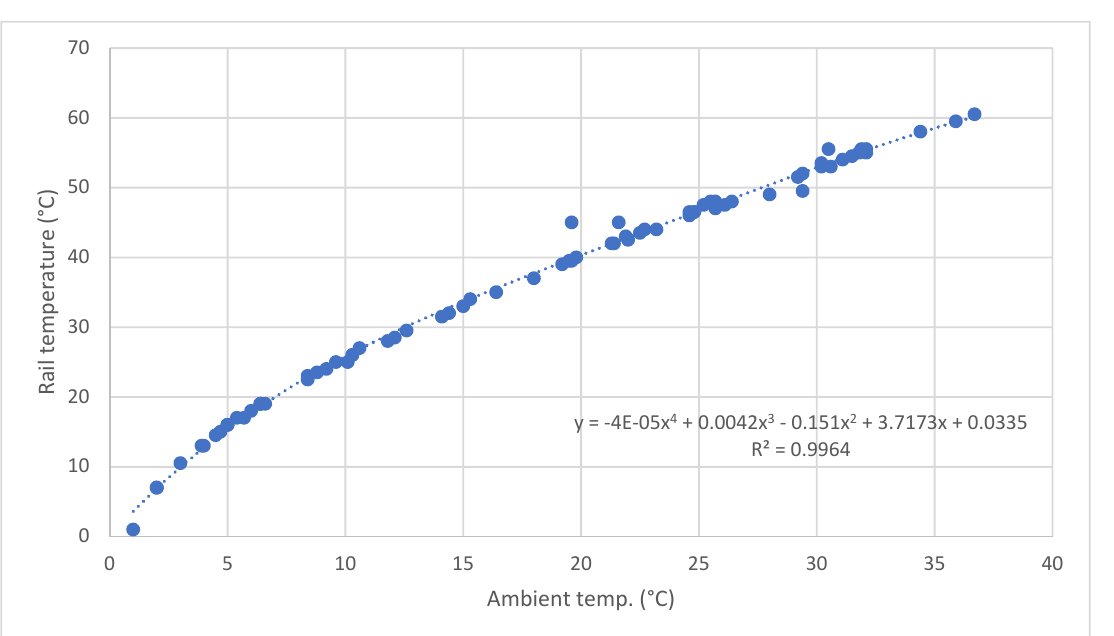
Figure 16. Temperature of the rail under load dependence on the ambient temperature (source: own work).